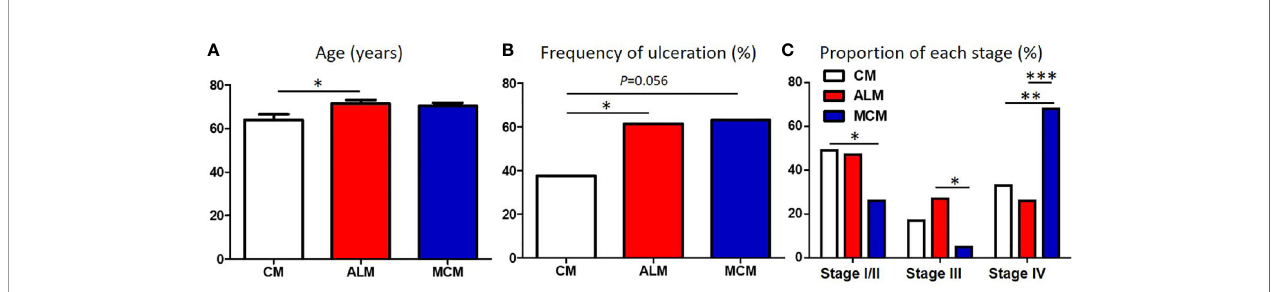
FIGURE 1 | Comparison of patients ’ background between each melanoma subtype. (A – C) Age (A) , frequency of ulceration (B) and proportion of each stage (C) in patients with cutaneous melanoma (CM), acral lentiginous melanoma (ALM) and mucosal melanoma (MCM) were shown. P -values was calculated using Mann- Whitney U test (A) and Chi square test (B, C) . * P <0.05, **<0.01, *** P <0.001.